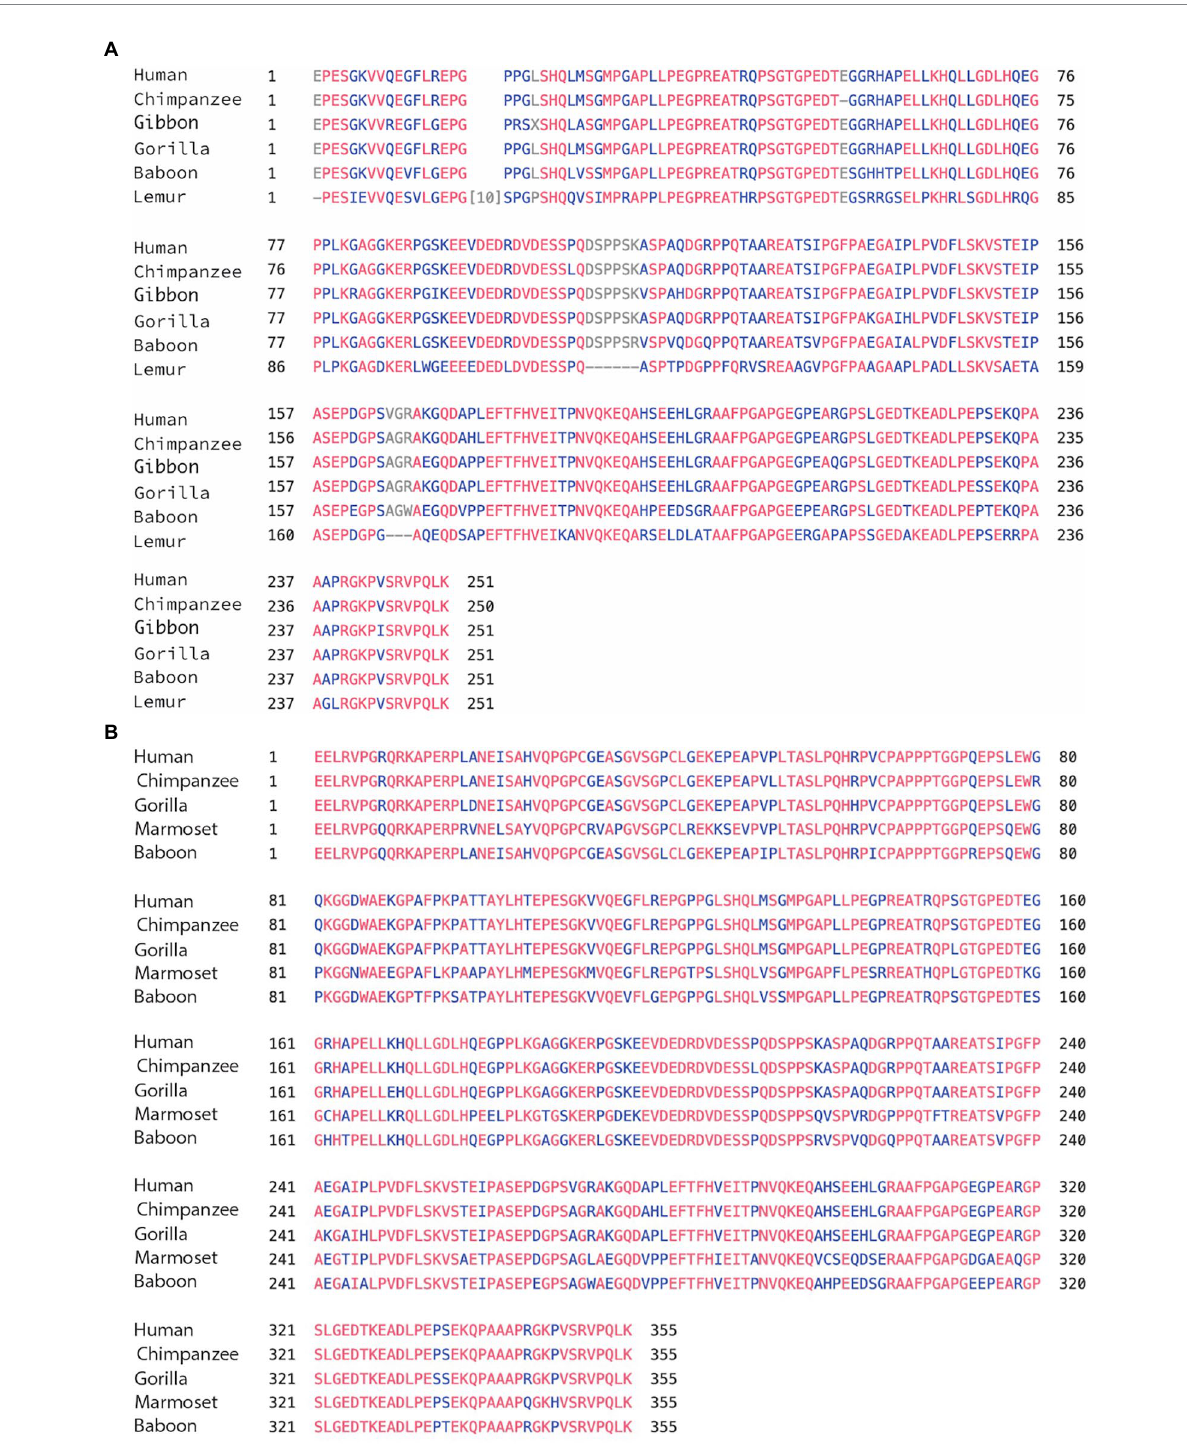
FIGURE 2 (A) Alignment of exon 4a in primates. Using the multiple alignment tool of COBALT for analysis of the 4a exon in primates including human, chimpanzee, gibbon, gorilla, baboon, and lemur. (B) Alignment of exon 4a-L in primates. Using the multiple alignment tool of COBALT for analysis of the 4a-L exon in primates including human, chimpanzee, gorilla, marmoset, and